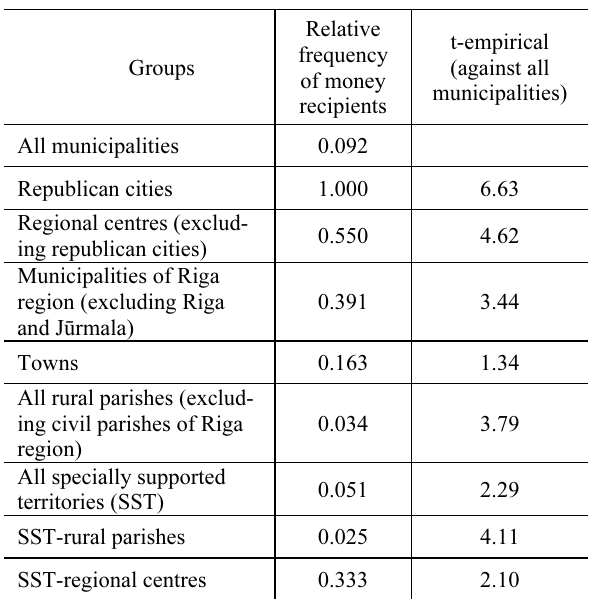
Table 11. Distribution of the money amount to structural fund